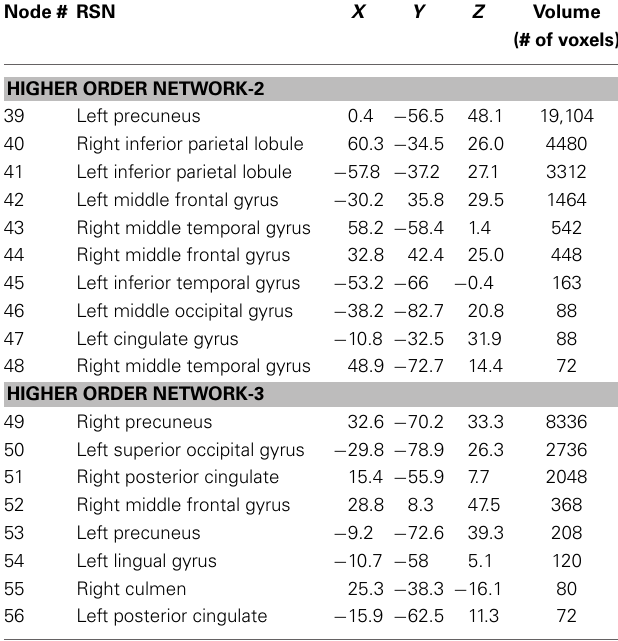
Table 2 | The 16 RSNs and their corresponding node